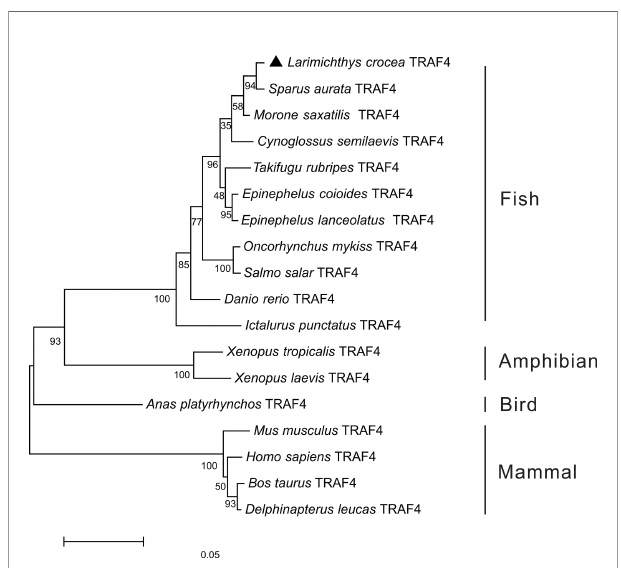
FIGURE 1 | Phylogenetic analysis of vertebrate TRAF4. The phylogenetic tree was constructed based on the alignment of amino acid sequences of teleost, bird, amphibian and mammal TRAF4 using the neighbor-joining method by MEGA version 7.0 software with 10,000 replications of the bootstrap test. The number on the branch represents the percentage of the boot value. The GenBank association numbers of these sequences used are as follows: L. crocea TRAF4, ON246166; Sparus aurata TRAF4, XP_030259023.1; Morone saxatilis TRAF4, XP_035536590.1; Cynoglossus semilaevis TRAF4, XP_008307618.1; T. rubripes TRAF4, XP_003968588.1; E. coioides TRAF4, AME21333.1; Epinephelus lanceolatus TRAF4, XP_033488065.1; O. mykiss TRAF4, XP_021443644.1; S. salar TRAF4, NP_001167069.1; D. rerio TRAF4, NP_991325.1; I. punctatus TRAF4, XP_017346543.1; Xenopus tropicalis TRAF4, NP_001005074.1; X. laevis TRAF4, NP_001087501.1; Anas platyrhynchos TRAF4, XP_038021542;